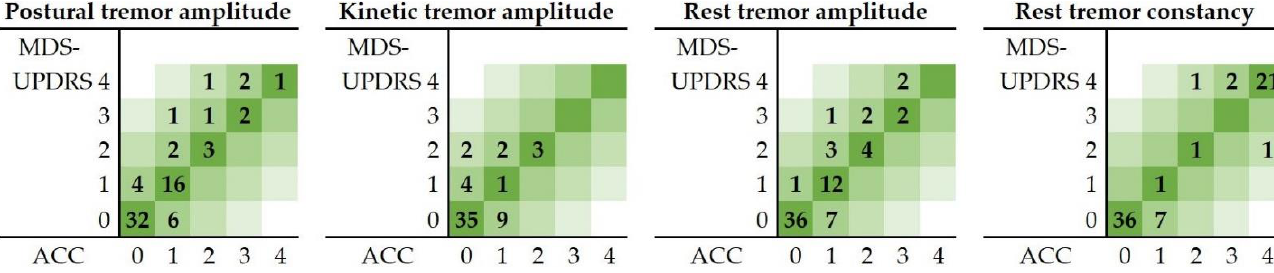
Figure 4. Contingency tables of the given MDS-UPDRS scores and calculated accelerometry (ACC) scores of the tremor tests in the patient population. Table 3. Agreement